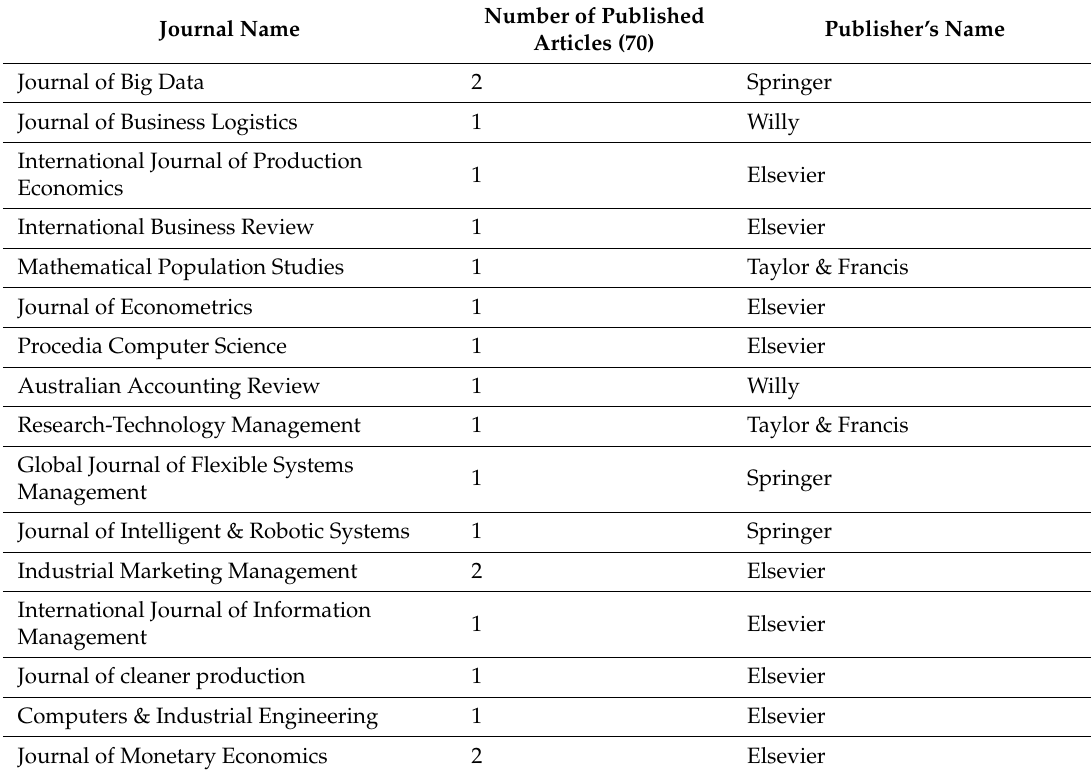
Figure 1. Systematic Framework for the Research Structure. Table 1. List of published papers relating to big data in